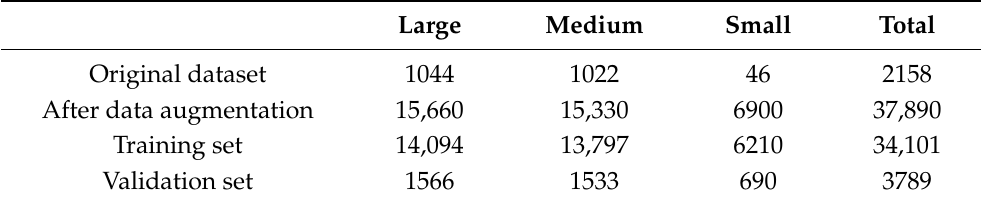
Table 1. Distribution of the